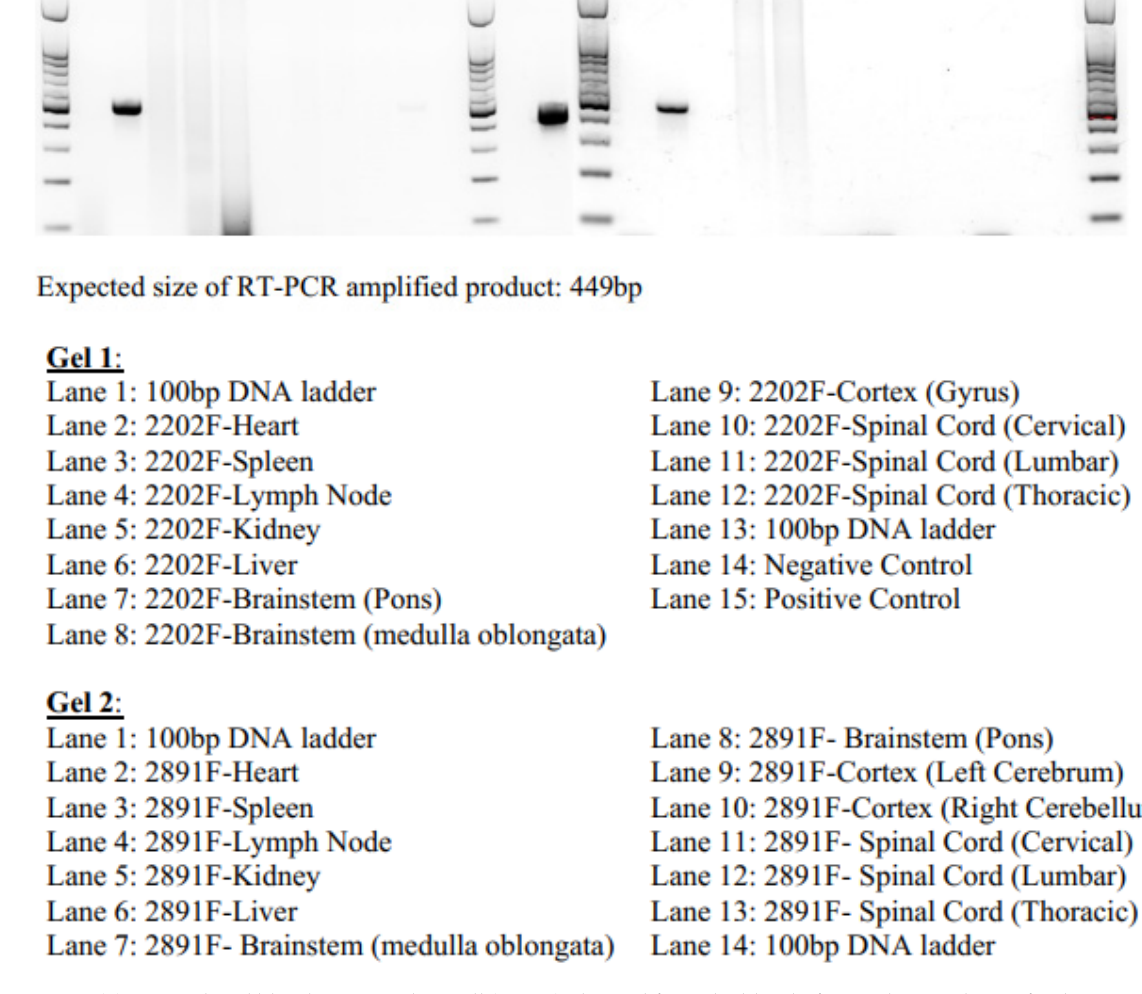
Figure 3. ( a ) A peripheral blood mononuclear cell (arrow), derived from the blood of a monkey on day 4 after being given an intravenous dose of enterovirus A71 (EV71:TLL β P20). Staining for the virus was carried out by indirect immunofluorescence using a commercial monoclonal antibody specific for the virus. ( b ) Photograph of GelRed-stained, electrophoresed agarose gels showing One-step RT-PCR amplified products from tissues derived from day 4 postinoculation monkeys (2202F, 2891F). A specific oligonucleotide primer pair was used for detection of enterovirus A71.